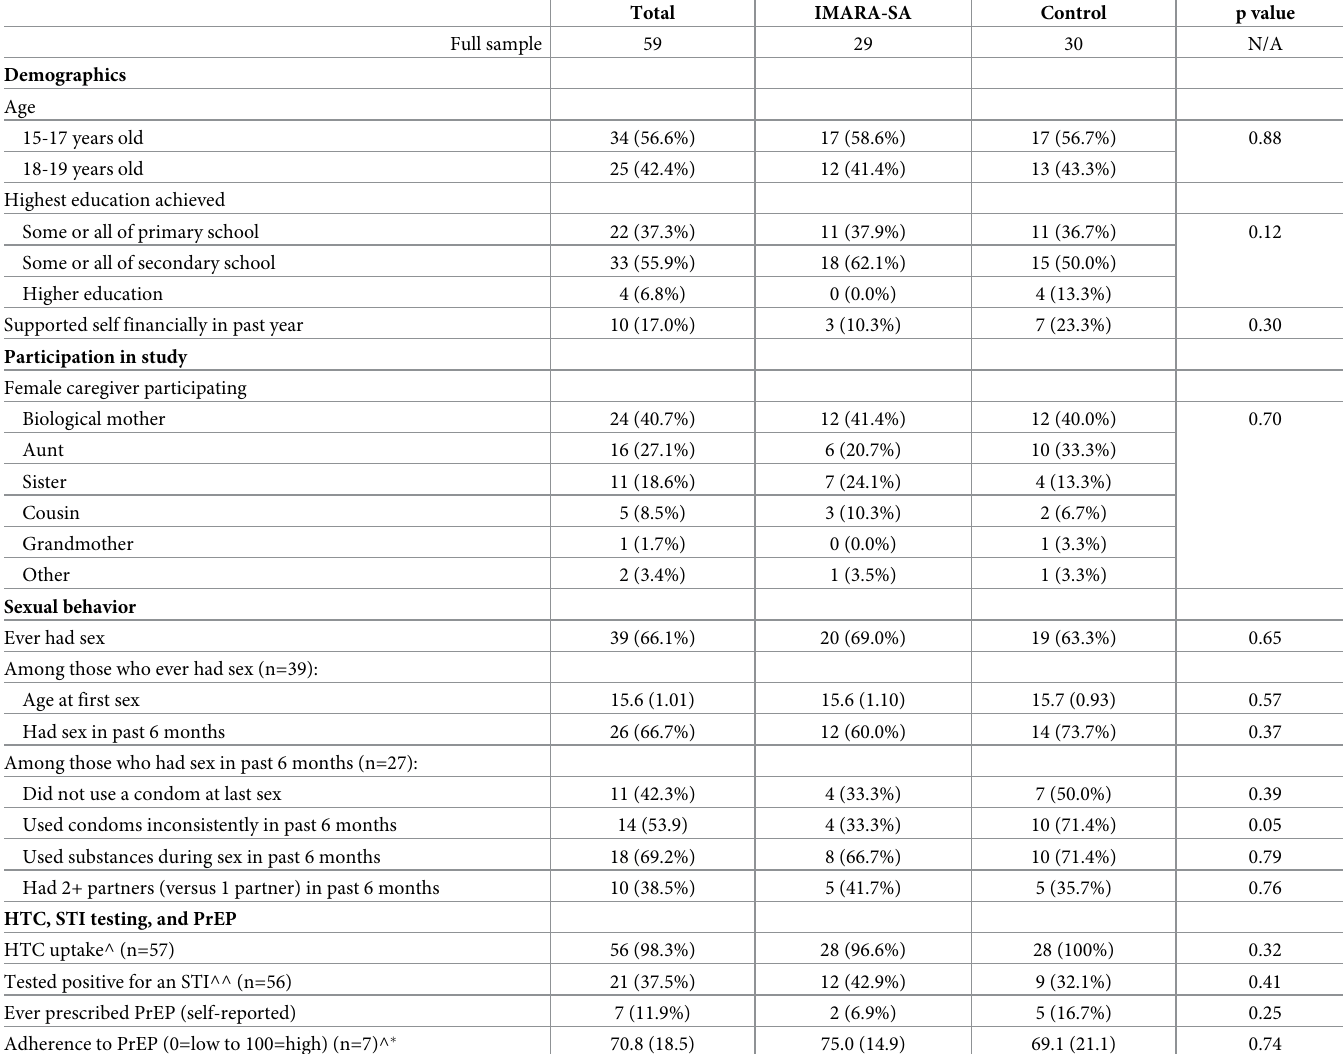
Table 1. Baseline characteristics of adolescent girls and young women by treatment